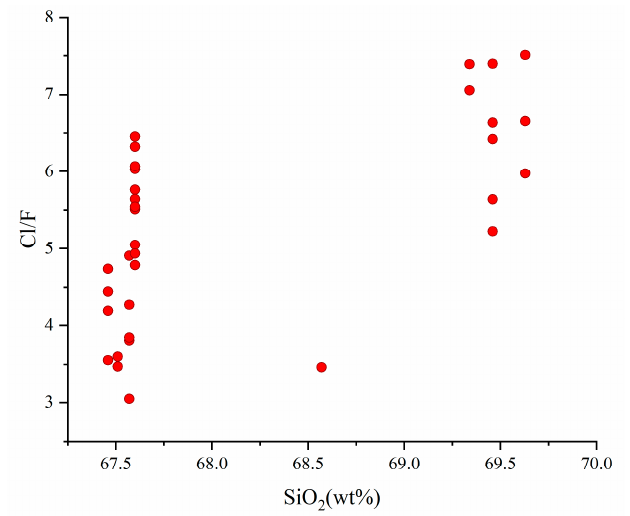
Figure 10. Plots of Cl/F versus SiO 2 in dacitic melts of the Eastern Manus